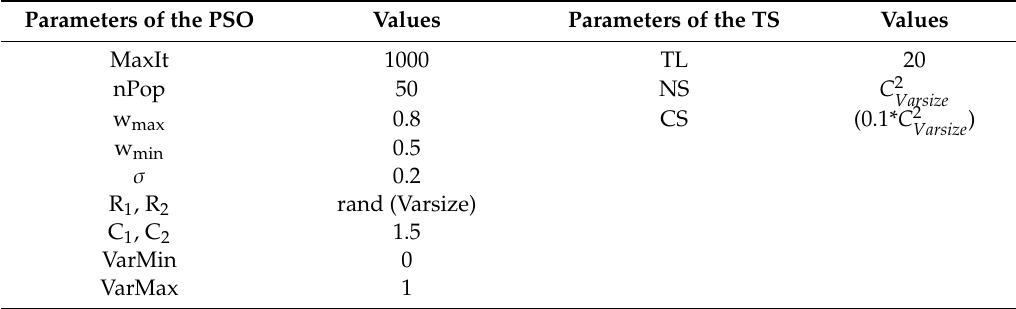
Table 4. Parameters connected to the particle swarm optimization (PSO)-tabu search (TS) algorithm. Parameters of the